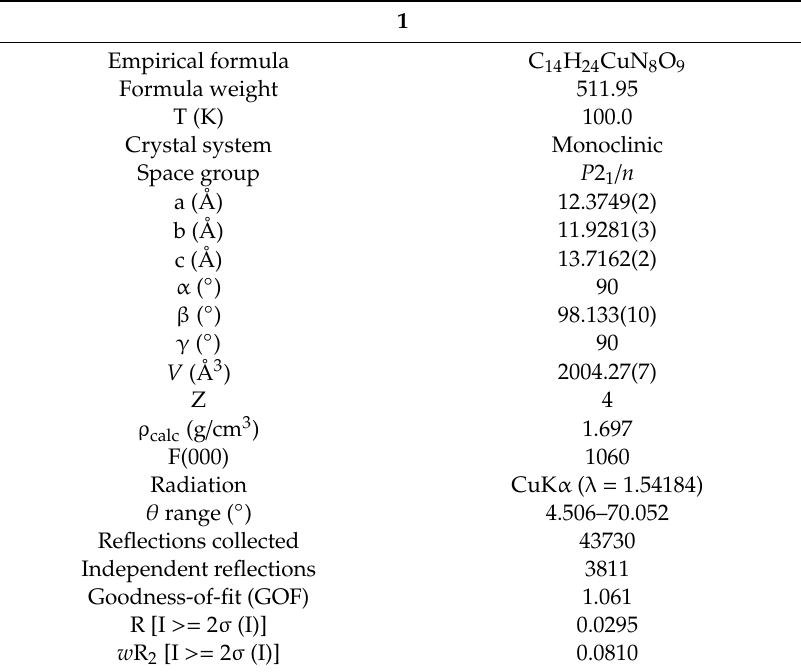
Table 1. Crystal data and structure refinement parameters for 1